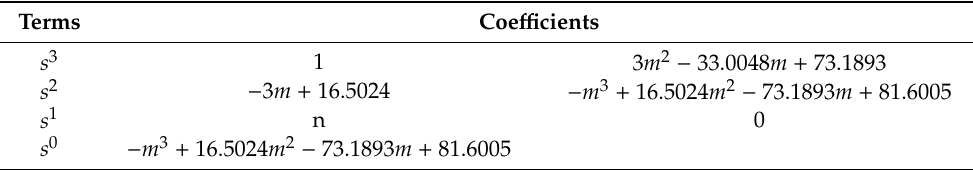
Table 3. The Routh array with λ = s − m